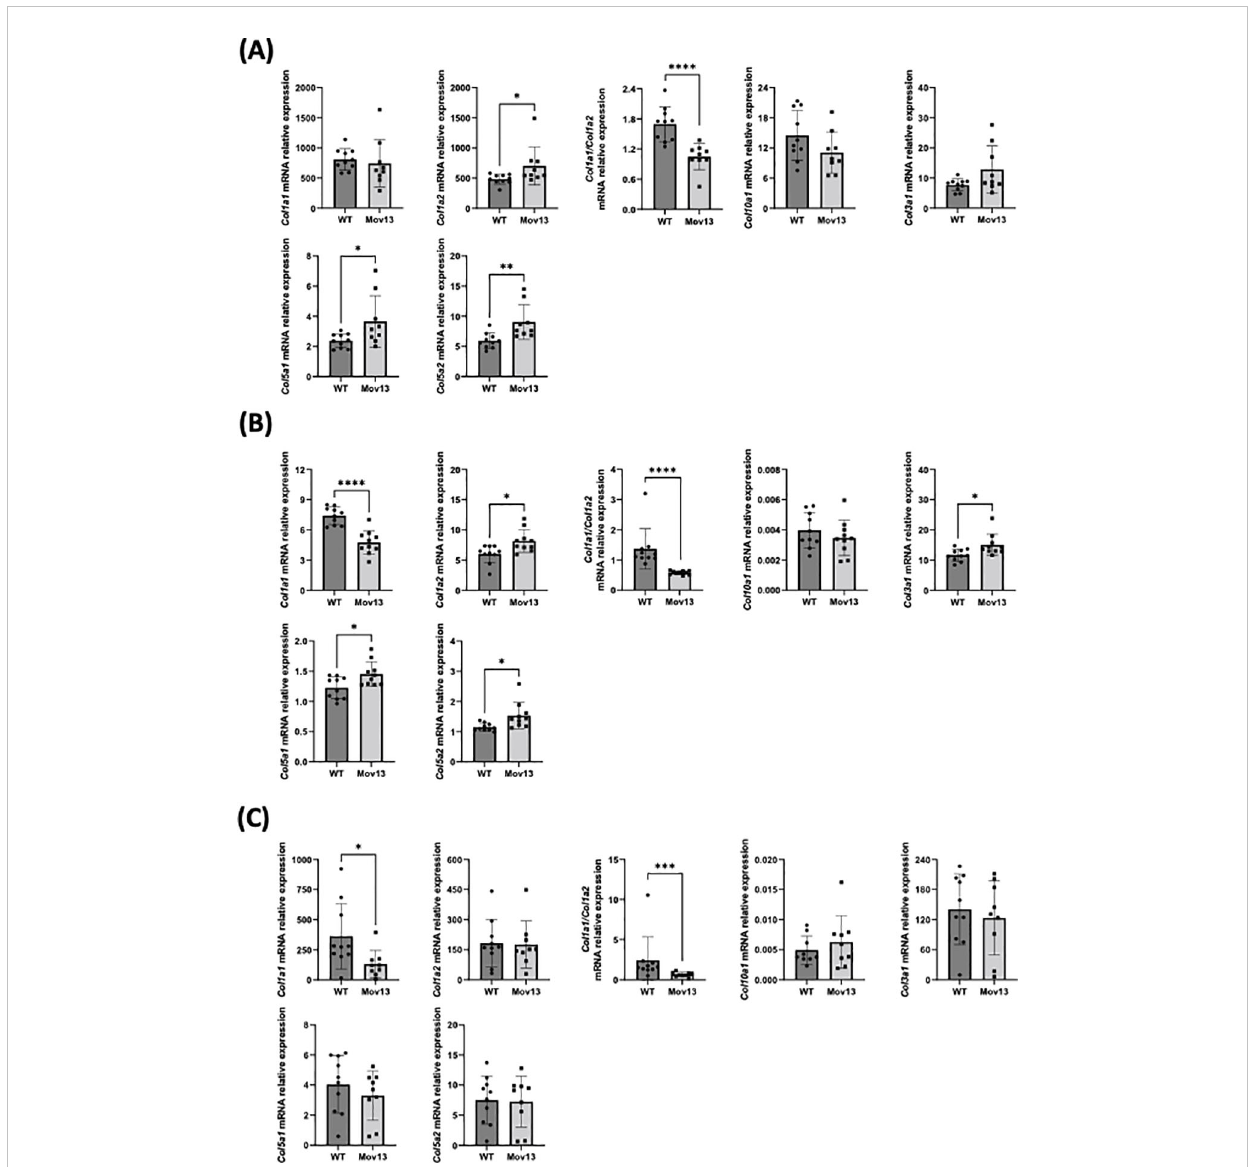
FIGURE 6 Relative mRNA expression of collagens in bone, heart and skin tissues. Relative mRNA expression of different collagen types in (A) bone, (B) heart and (C) skin tissue of Mov13 and WT mice. Relative mRNA expression is represented as DD Ct values. P-values are indicated as follows: